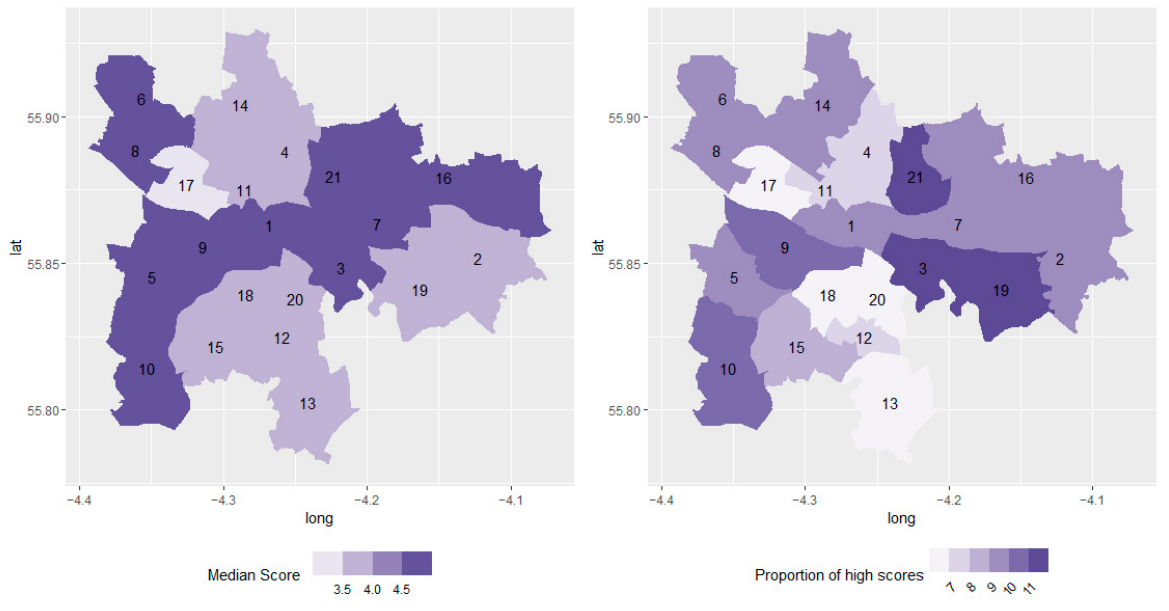
Figure 1. Median and high scores by electoral ward in Glasgow. Median scores ( left ) and proportion of children with high scores ( right ) from 2010–2017. 1. Anderston/City, 2. Baillieston, 3. Calton, 4. Canal,